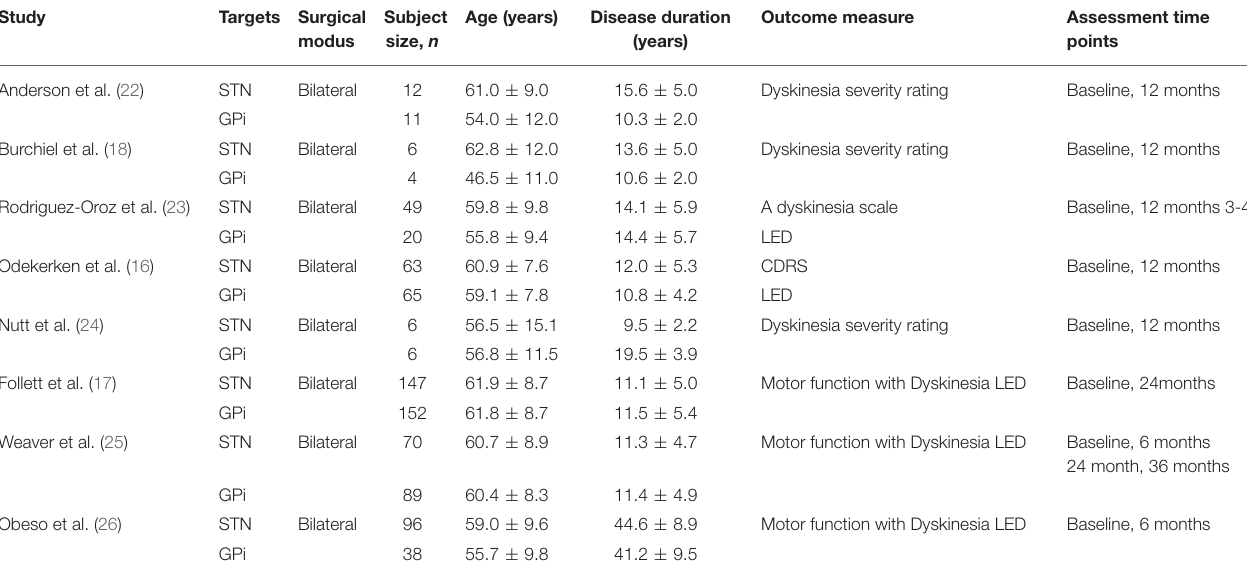
TABLE 1 | Characteristics of included controlled